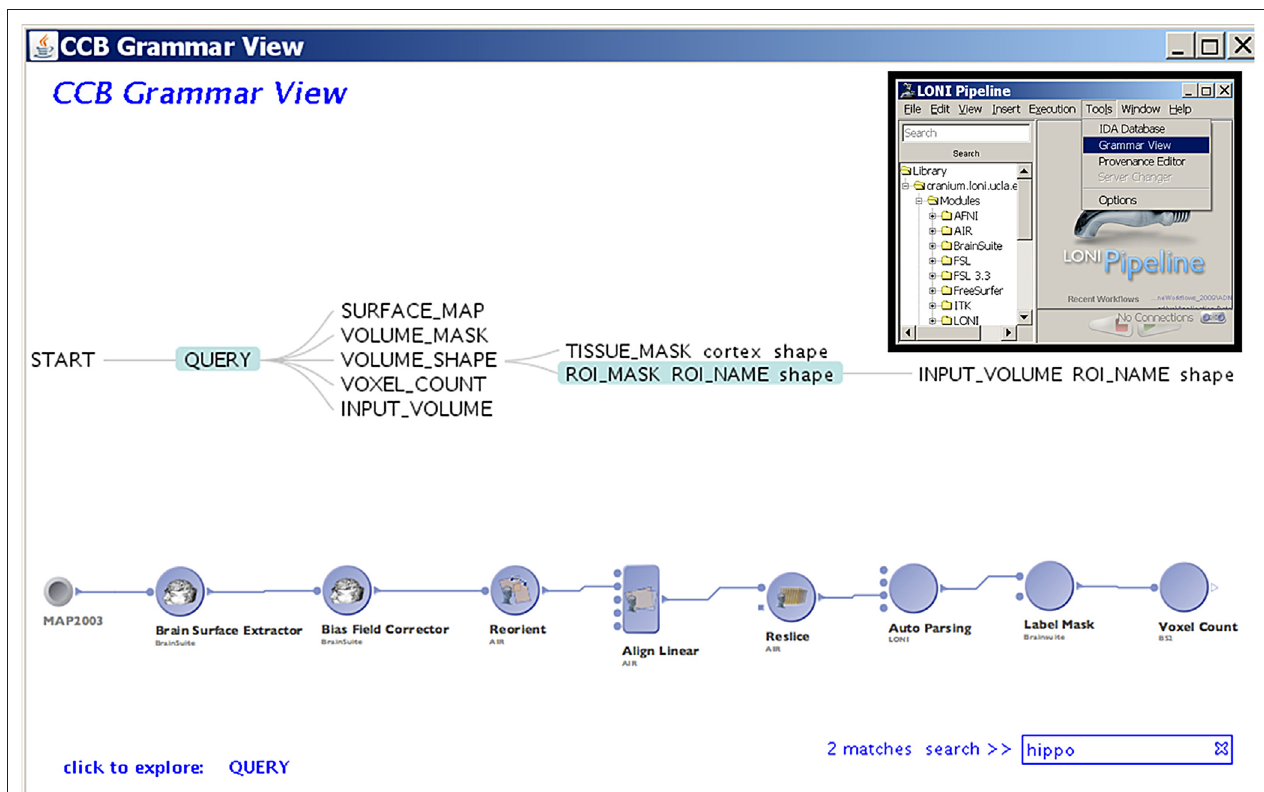
FIGURE 1 | LONI Pipeline intelligence component uses key-words to automatically generate a hierarchical interface and the complete analysis workfl ow, which represents the proposed study protocol, using semantic